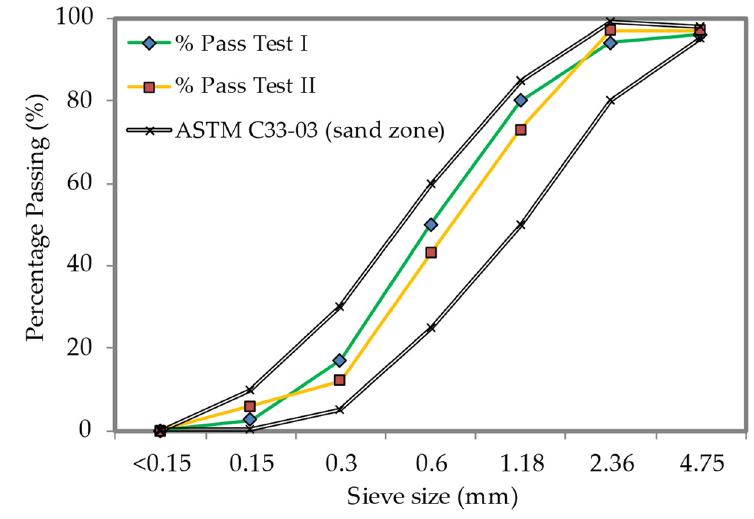
Figure 1. Fine sand particle size distribution.